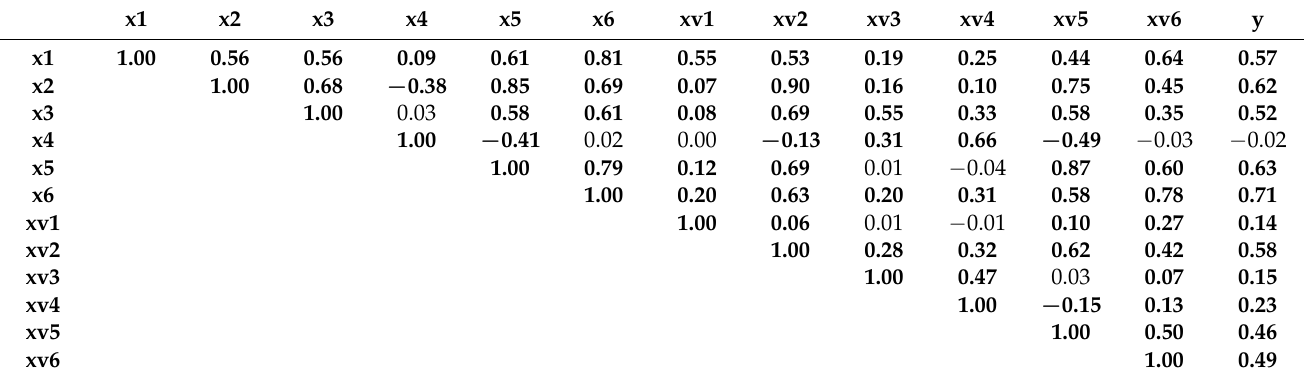
Bold character represents significant correlation with significant level